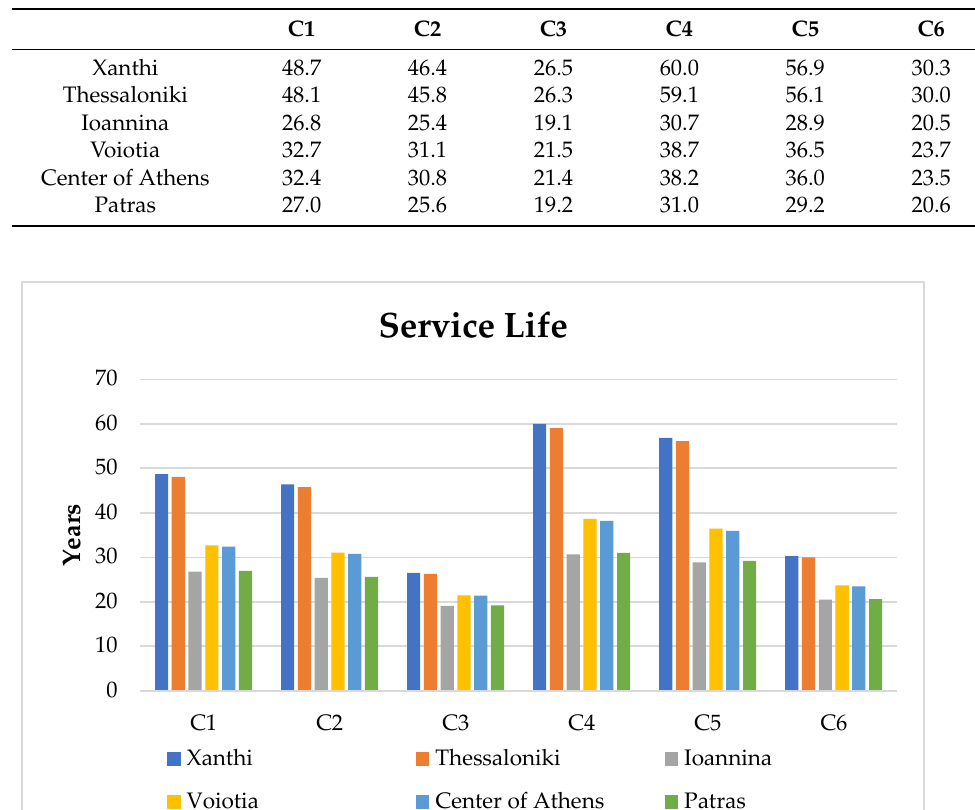
Table 29. Service life (years) of concrete mixtures due to carbonation.